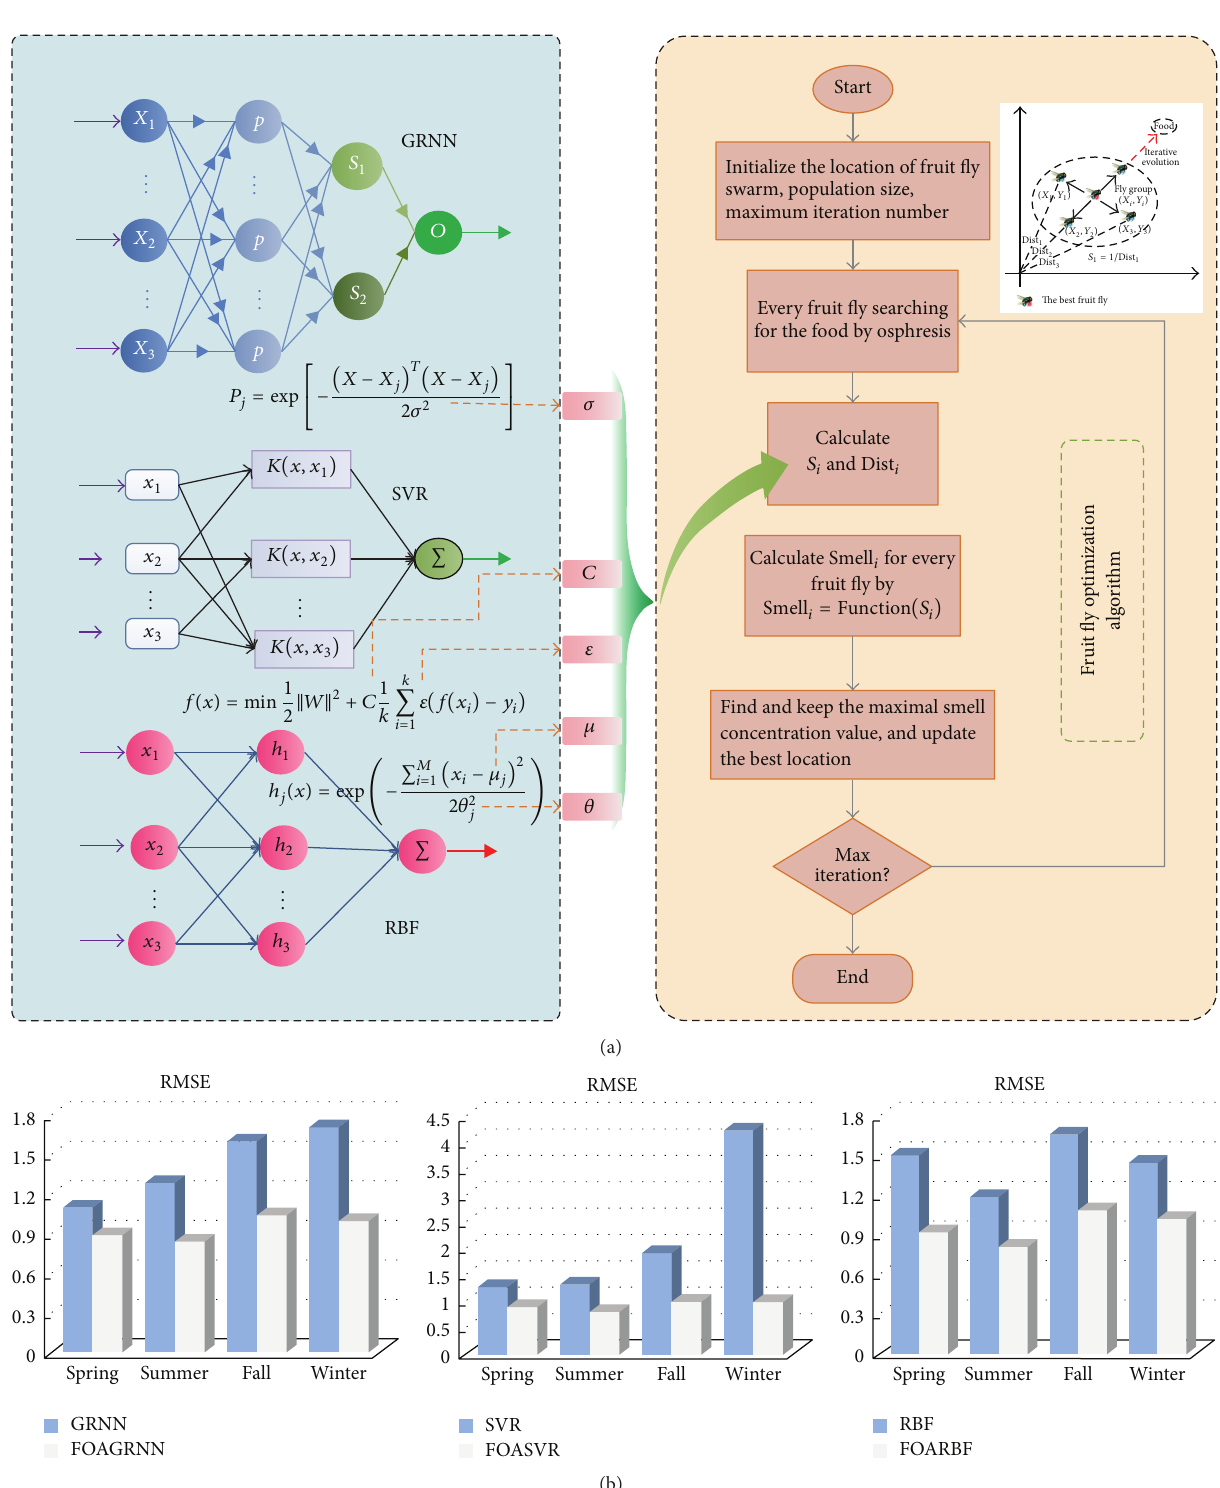
Figure 6: The procedures of RBF, GRNN, and SVR optimized by